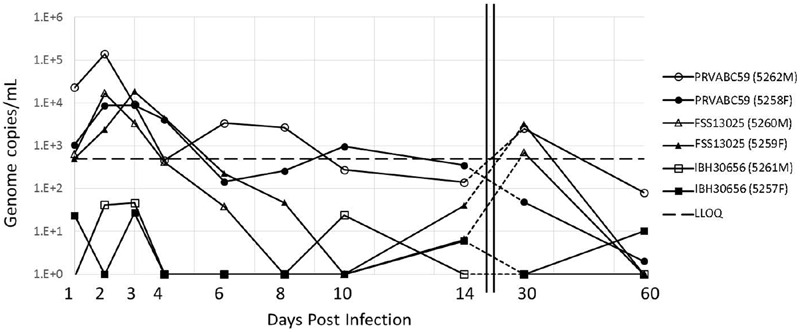
Viral load in the serum of ZIKV infected cynomolgus macaques. Animals were grouped into three cohorts, each containing a male (opened symbols) and female (closed symbols). Each cohort was challenged with ZIKV isolates at the dose indicated with either PRVABC59 (●), FSS13025 (▲), or IBH30656 (■). The serum viral load was determined using qRT-PCR at various days p.i. Notably, the serum viral load peaks around day 2–3 p.i. The LLOQ was previously determined to be 500 copies/mL and is indicated by the black dashed line.